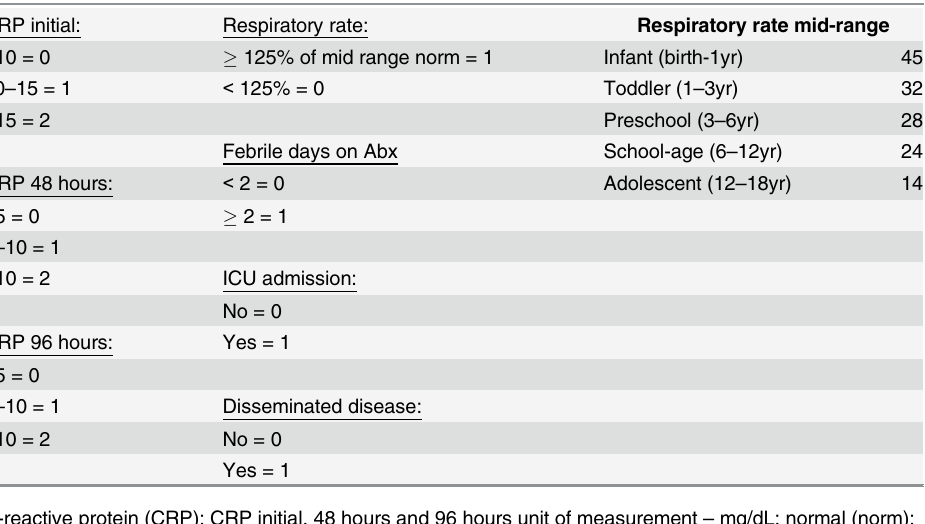
Table 2. Severity of Illness Scoring